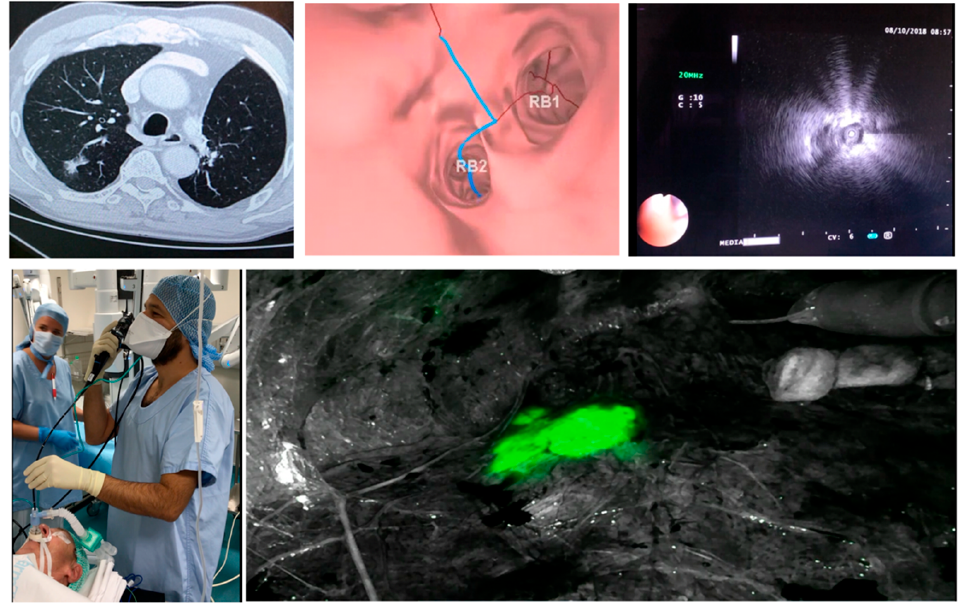
Figure 3. Dye marking using virtual bronchoscopy + R EBUS, courtesy of Dr. Samy Lachkar.